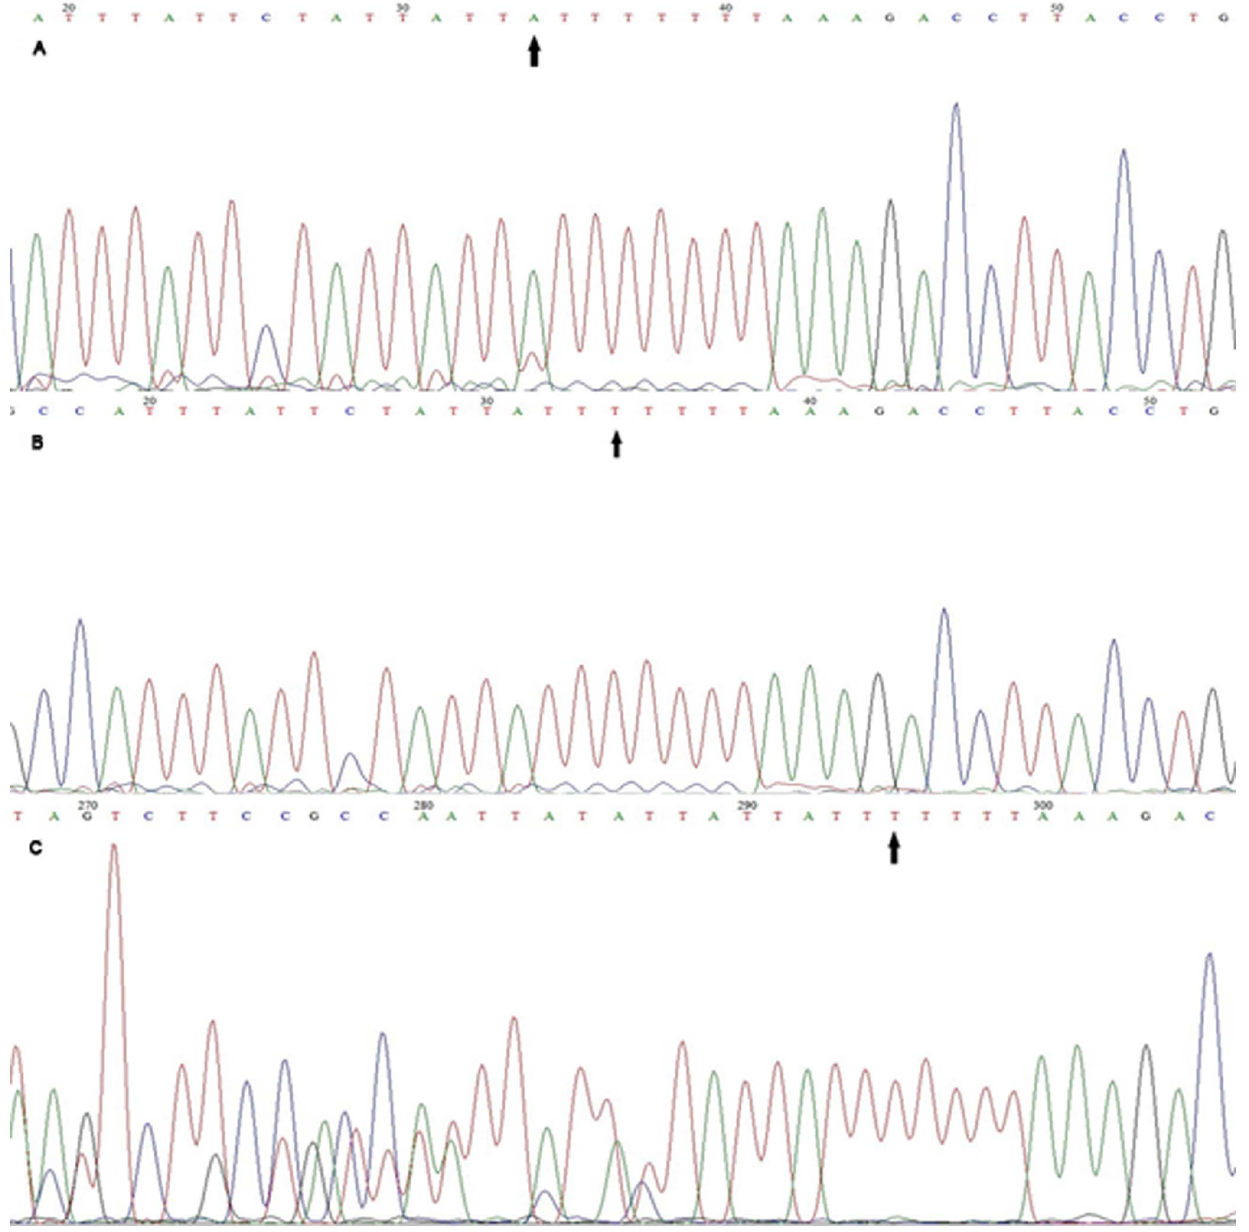
Figure 5. Sequencing results of Foxp3 -6054. Figure 5A was the sequencing of Foxp3 -6054 A/A genotype; Figure 5B was the sequencing of Foxp3 -6054 T/T genotype. Figure 5C was the sequencing of Foxp3 -6054 T/A genotype. The arrow part was the SNP